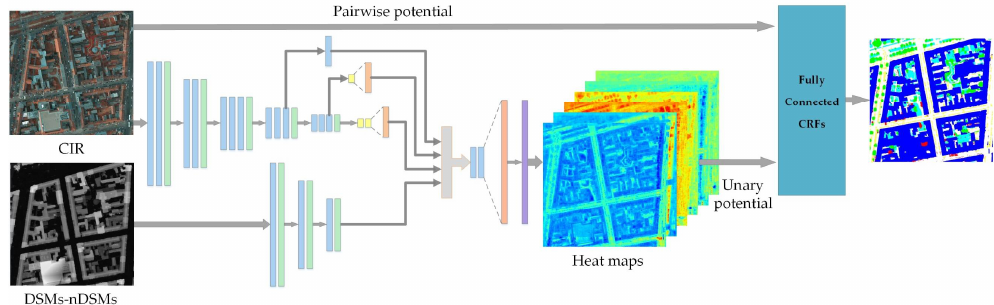
Figure 6. General procedure of the image segmentation.